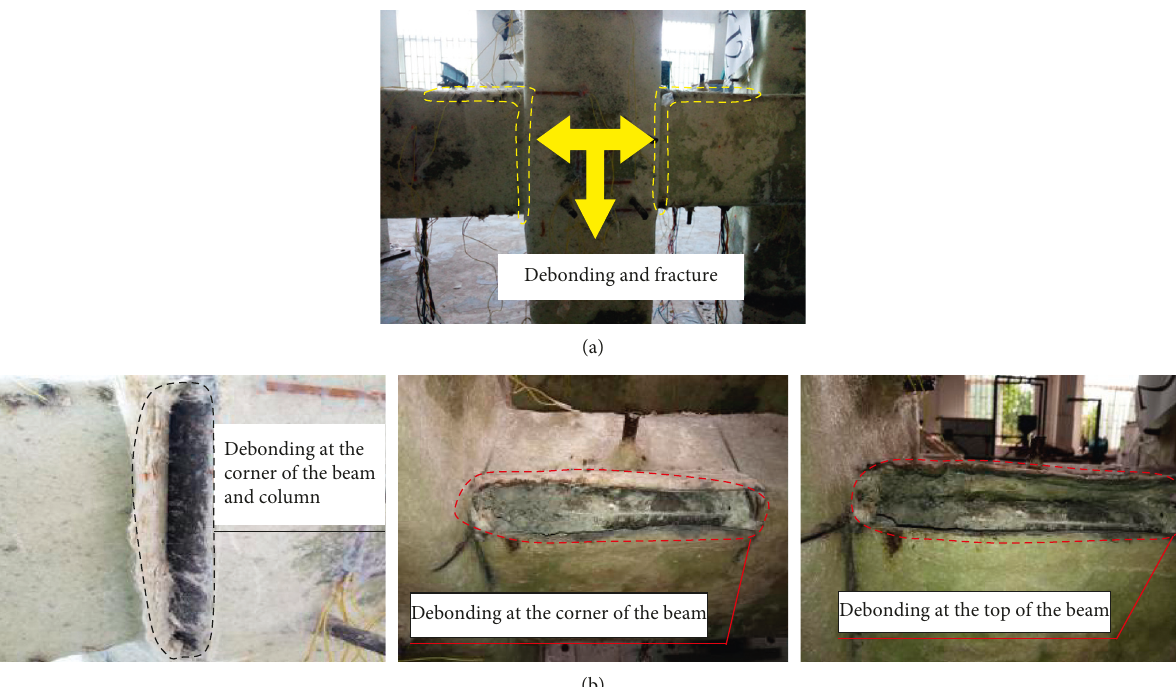
Figure 6: Failure characteristics of the strengthened specimen. (a) Failure mode of the specimen and (b) debonding in the cutting